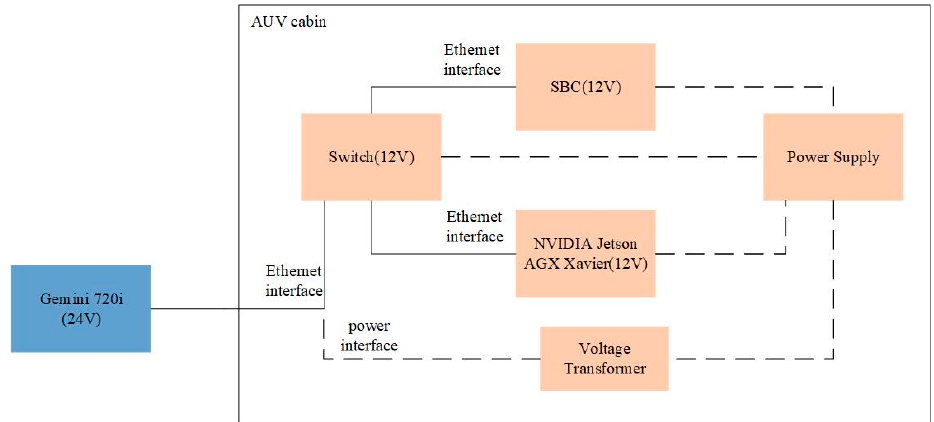
Figure 15. An illustration of the hardware connection between devices in our real-time detection experiment. Note that the dotted line represents the connection between the device and power supply. Since the power supply voltage of Gemini 720i is different from other embedded devices, its power is supplied with a transformer.